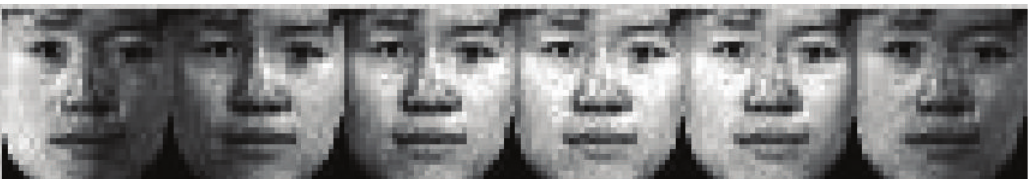
Figure 4: Some test samples from the PIE face database from the same class.